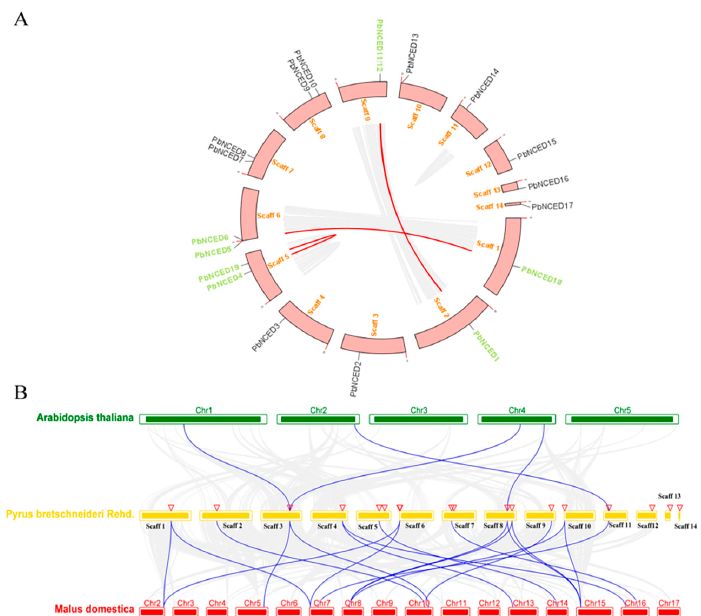
Figure 4. ( A ) Synteny analysis of PbNCED genes. Gray lines indicate all synteny blocks in the pear genome, whereas segmental duplicated homologous genes are indicated with red lines. ( B ) Synteny analysis of NCED genes between Arabidopsis , pear, and apple. The gray lines in the background indicate the collinear blocks with in pear and other plant genomes, while the blue lines highlight the syntenic NCED gene pairs. The chromosome number is shown at the top of every chromosome.